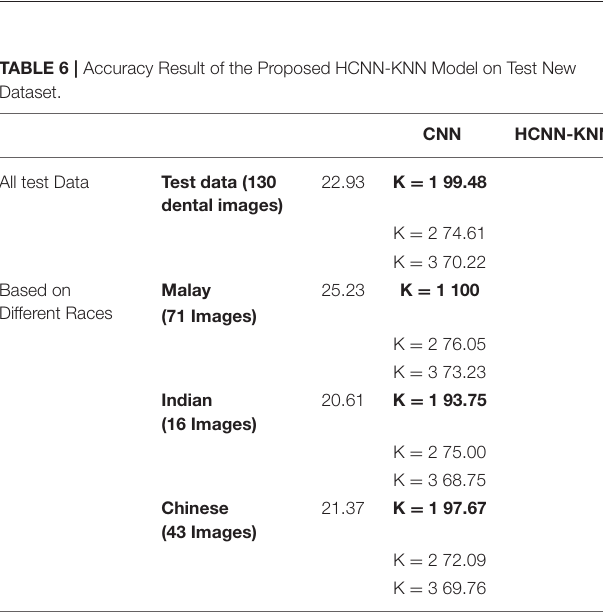
FIGURE 7 | Different images of test data to evaluate the orthodontics (malignant) of the proposed model.